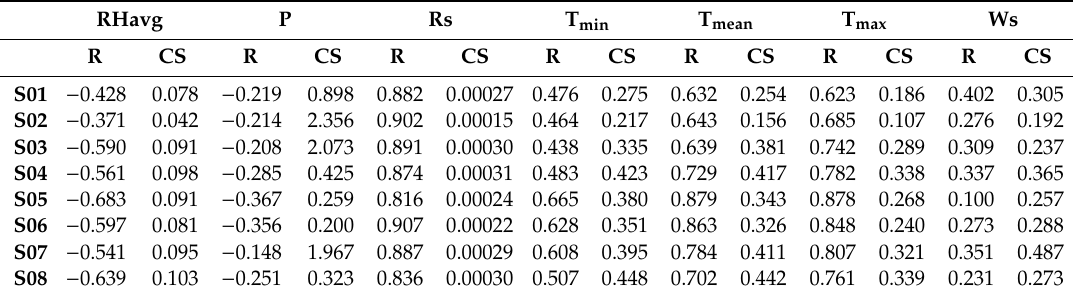
Figure 7. Projection of seasonal evapotranspiration change under climate scenarios RCP 4.5 and RCP 8.5 for 2030–2049. Table 7. Sensitivity and correlation coefficient of climatic parameters with the reference evapotranspiration. RHavg P